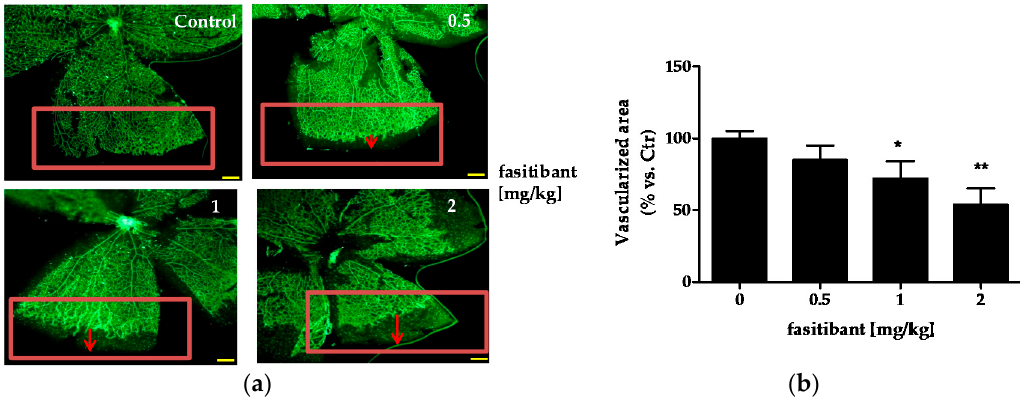
Figure 1. Fasitibant reduces the extent of retinal vascularization in mouse pups. ( a ) pups were treated with or without fasitibant (NaCl 0.9% = Control; fasitibant, 0.5 to 2 mg/kg, in 50 μ L, i.p.) and then retinas were dissected at P8 and stained with isolectin, IB4-488. Magnitude 4×, scale bar = 100 μ m; ( b ) quantification of retinal vessels. Retinal whole-mounts from P8 pups were stained for endothelial cells with IB4-488. For measurement of the vascularized area at the retinal edges, the retinal edges were outlined with image-processing software (Photoshop Adobe Systems, Adobe Photoshop Elements 11). The density of vascularization in the outlined areas was quantified by ImageJ software, version 2.0.0-rc-43/1.50e, U.S. National Institutes of Health, Bethesda, MD, USA; and expressed in relation to the control areas (% vs. Ctr). Data are the mean of 10 outlined areas, obtained from at least five flower-like structures. Arrows indicate the distance from vascularized area to retinal edge. * p < 0.05, ** p < 0.01 vs. Ctr.